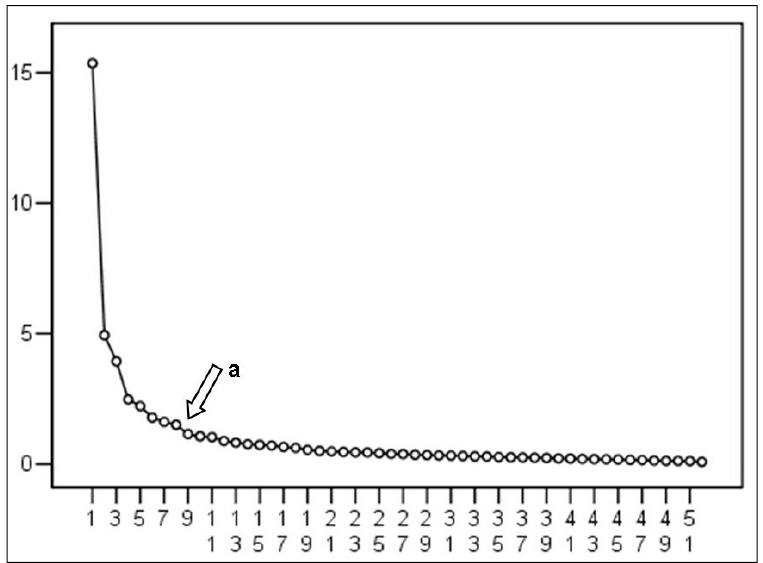
Figure 1. Cattel slope.